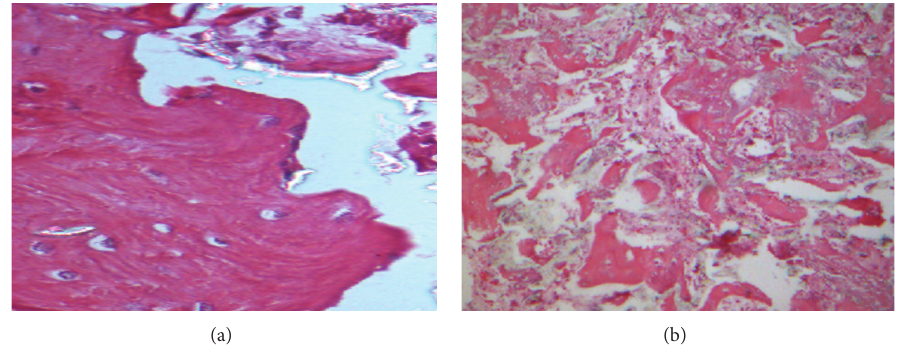
Figure 6: In the first eight weeks after the end of the extension: (a) the histologically morphological observations of the extension area of group A and (b) the histologically morphological observations of the extension area of group B.